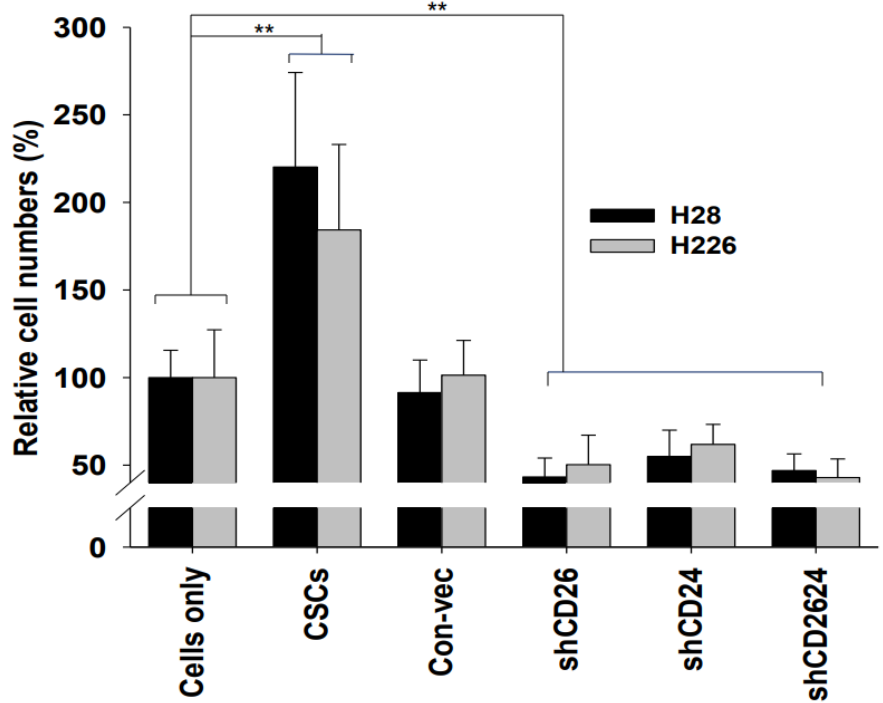
Figure 3. Cell invasion potential of MM cell lines. Cell invasiveness was determined by using a Matrigel invasion chamber. MMs were seeded into the upper chambers in serum-free medium. The outer chambers were filled with medium containing 10% FBS. After 48 h, the non-invading cells were removed by swabbing the top layer. After removal of non-invasive cells, the invaded cells were stained with Diff-Quik Stain Set and quantified. Mean ± SD ( n = 3), p < 0.01 (**).